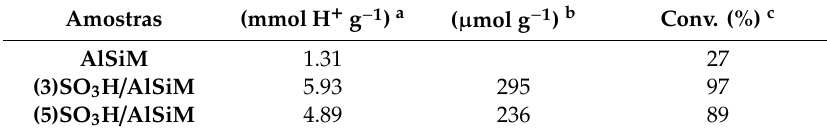
Table 4. Evaluation of acidity of the prepared materials and conversion of